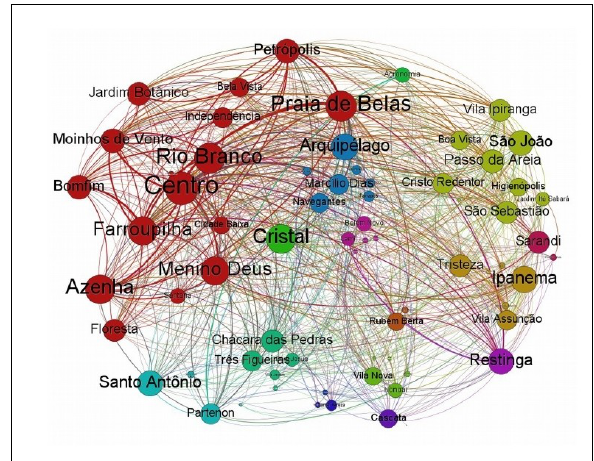
Figure 6. Districts network (projection from original two-mode